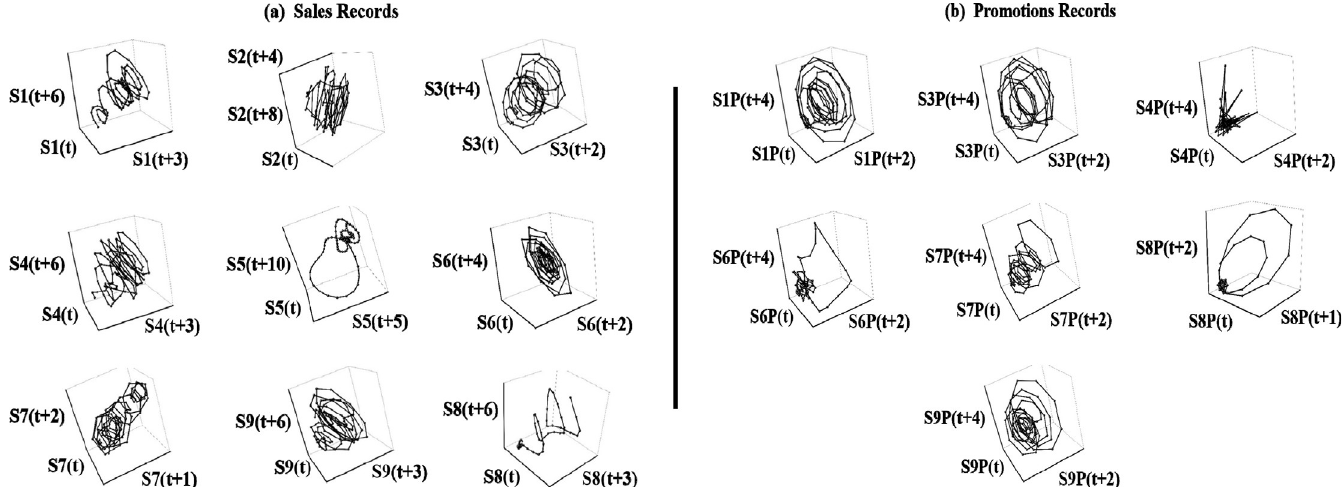
Fig 9. Attractors reconstructed from Tesco dataset. We successfully reconstructed low-dimensional shadow attractors from the perspectives of stationary (a) sale and (b) promotion signals. Several of the attractors exhibit striking geometric regularity characterized by oscillatory behavior detected in signal processing.